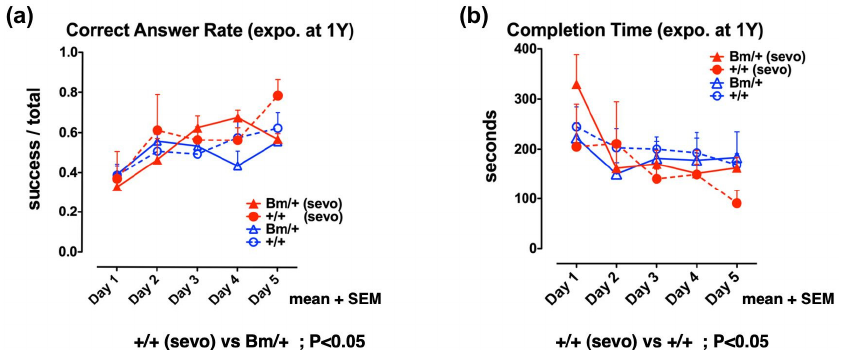
Figure 4. Anesthetic exposure had positive effects on spatial working memory in adult wild-type mice, but not mutant BiP mice. Eight-arm radial maze testing was performed in adult wild-type mice (+/+; circles) and mutant- Bip mice (Bm; triangles) 7 days after sevoflurane (sevo) exposure (+/+ sevo, n = 4, closed red circles; Bm/+ sevo, n = 5, closed red triangles) and without exposure (+/+, n = 7, open circles; Bm/+, n = 10; open triangles). Tests were performed over 5 days. Significance was determined by one-way repeated measures ANOVA followed by Bonferroni’s multiple comparison testing. ( a ) Correct answer rates are shown as the mean value for each group + standard error of the mean (SEM). The correct answer rate was defined as the ratio of successful attempts to the number of overall attempts (0.0–1.0). ( b ) Completion times represent the mean for each group + SEM.